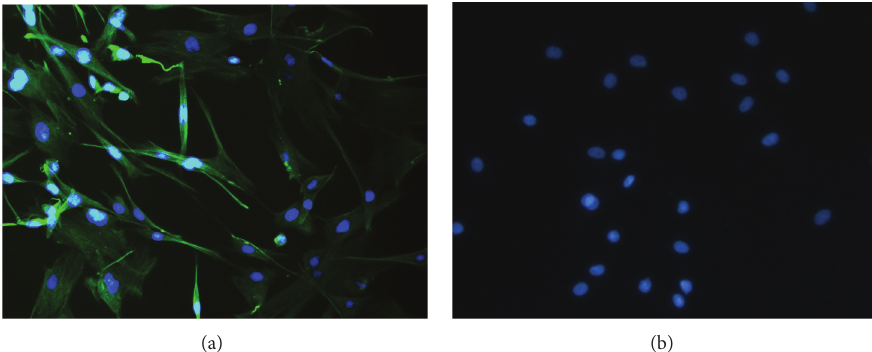
Figure 1: Characterisation of SFs by immunofluorescence. (a) SFs from thethird to sixth passage were stained with antibody against vimentin. (b) SFS from the third to sixth passage were stained with antibody against